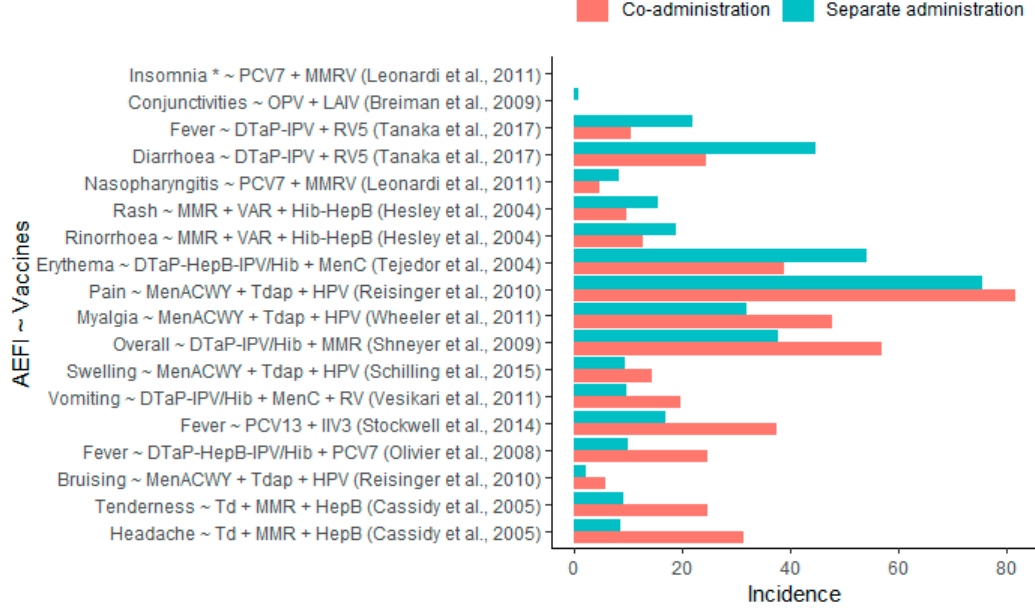
Figure 4. Incidences of adverse events following immunization (AEFIs) with statistically significant differences following co-administration compared to separate administration. *No incidences